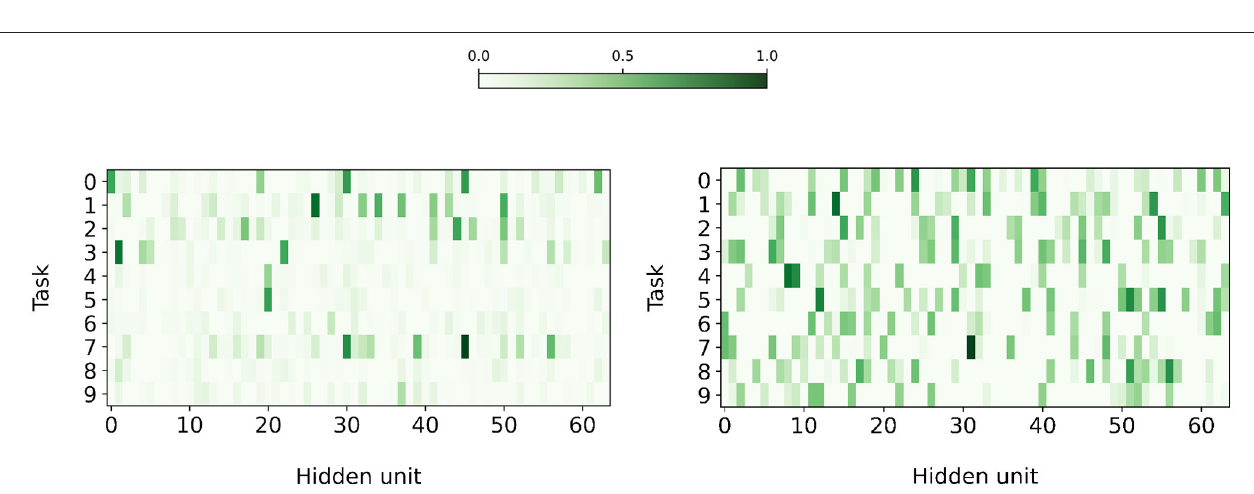
FIGURE 10 | The fraction of instances for which each of the first 64 hidden units in the hidden layer became active (after applying k WTA), when training an Active Dendrites Network on MT10 tasks (Left) and 10 permutedMNIST continual learning tasks (Right) . Both figures separate instances by task. For MT10, the figure tests the trained RL policy on each task three times during evaluation. For permutedMNIST, the figure uses 5,000 randomly-chosen test examples across all tasks. Note that each hidden layer contains more than 2,000 hidden units, but we show just 64 for ease of